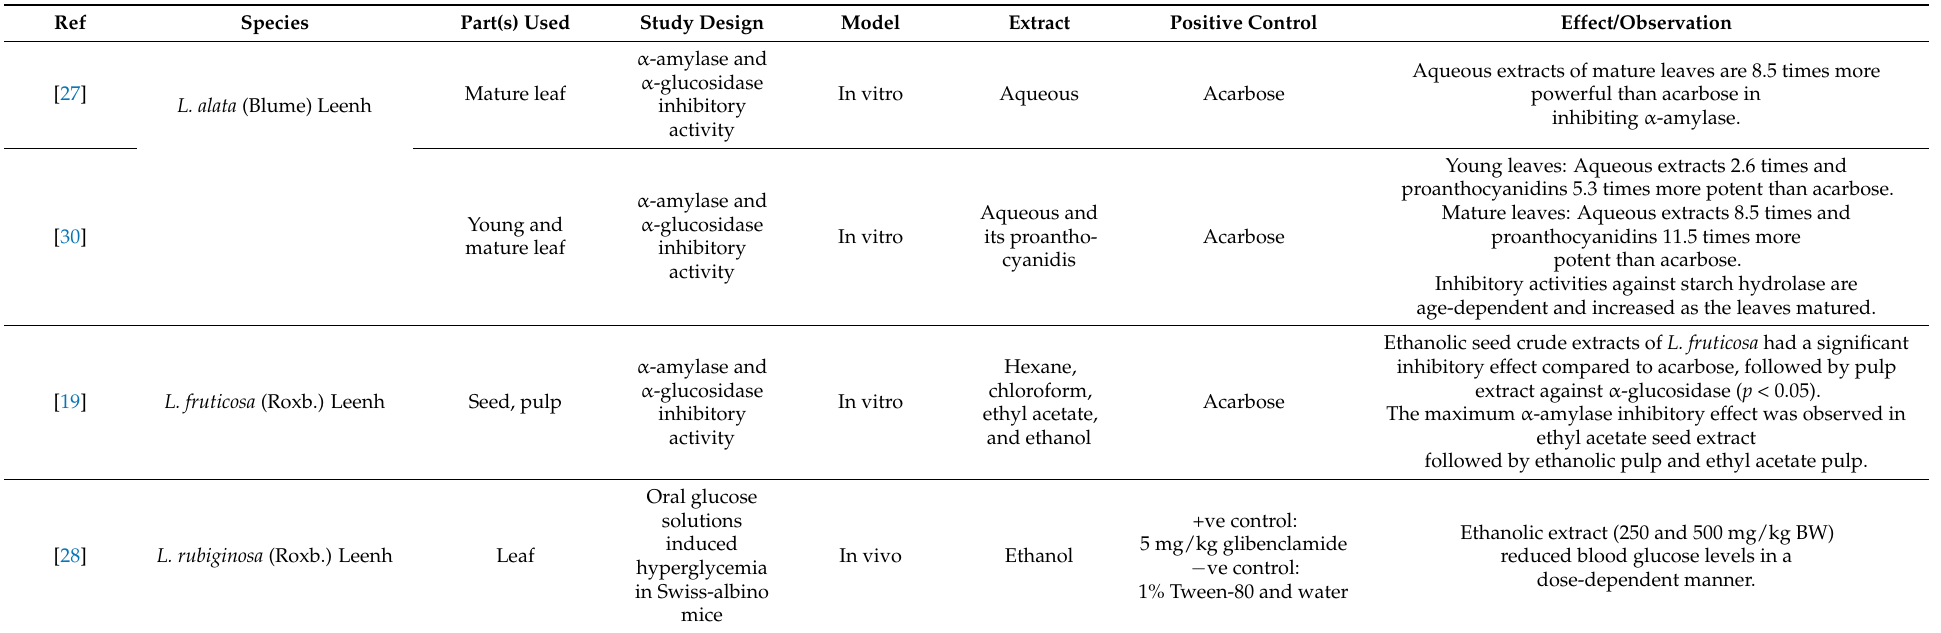
Table 6. Summary of the methods and antihyperglycemic activities of genus Lepisanthes